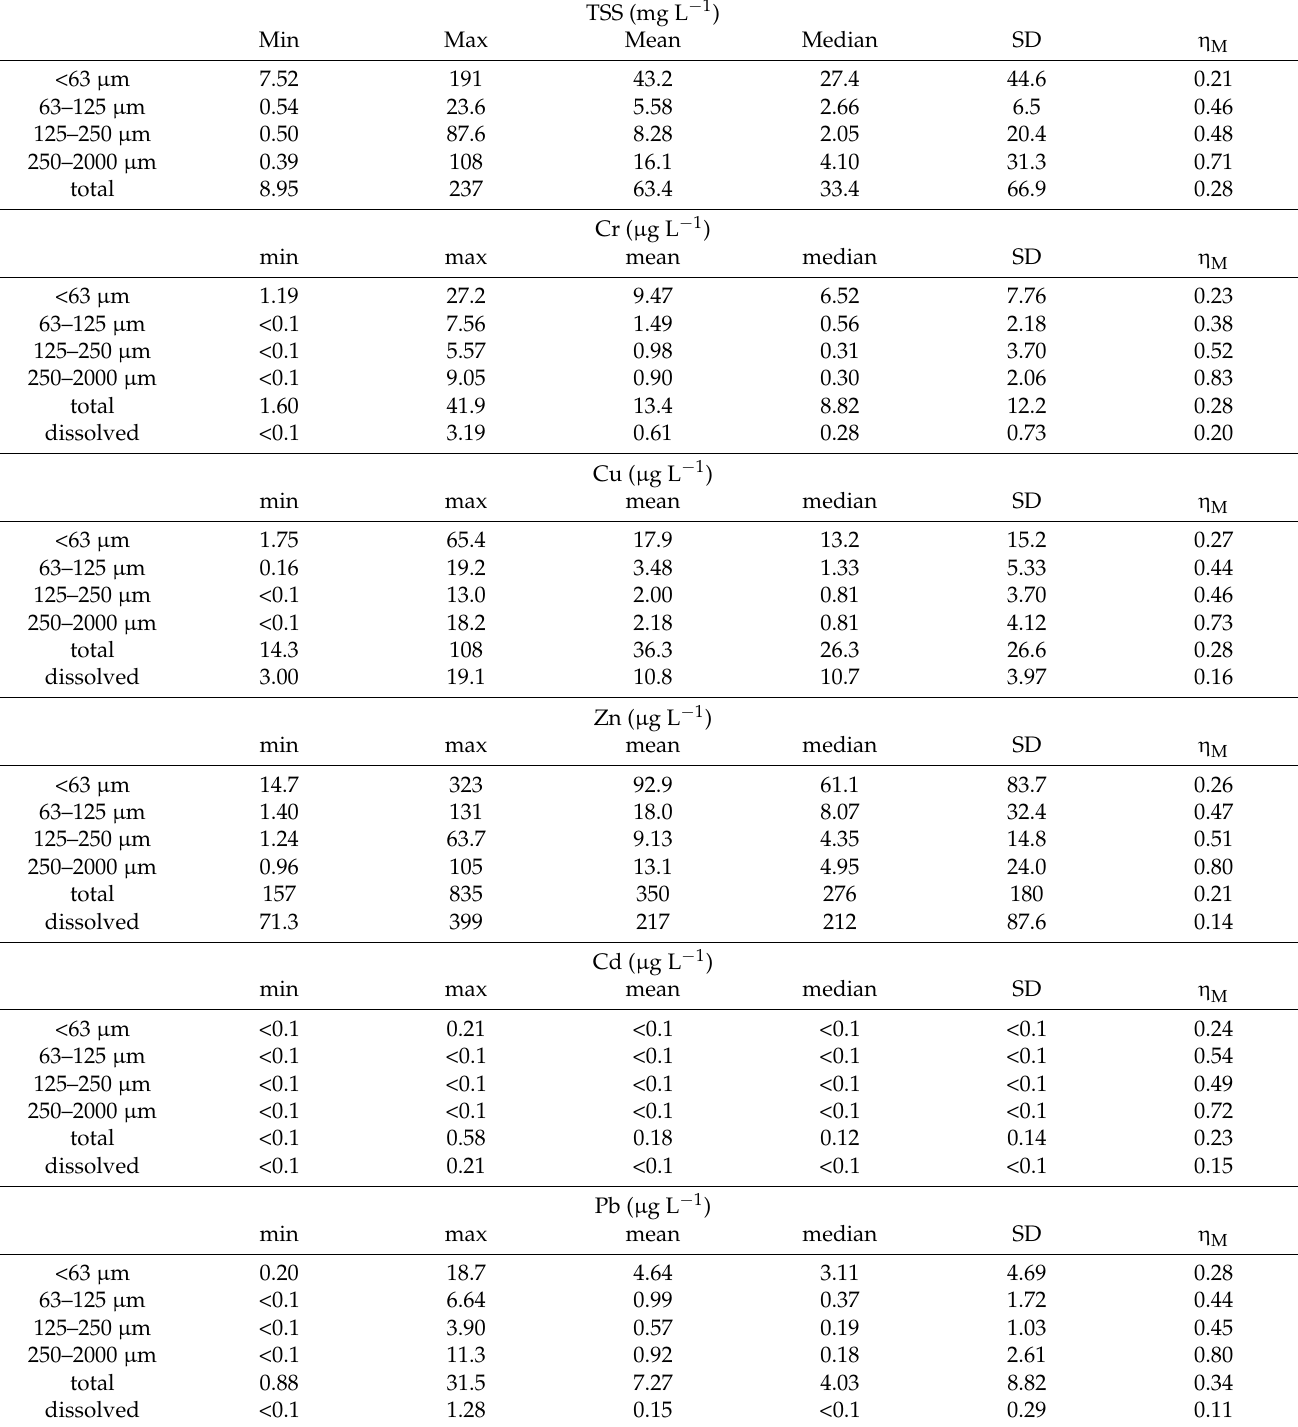
Table 1. Descriptive statistics of solids, heavy metals, and mean treatment efficiency in the respective particle size fractions for samples collected in 2018 (n = 17). For metals, “total” includes the dissolved and the particulate-bound fraction. With SD as Standard Deviation and η M as mean treatment